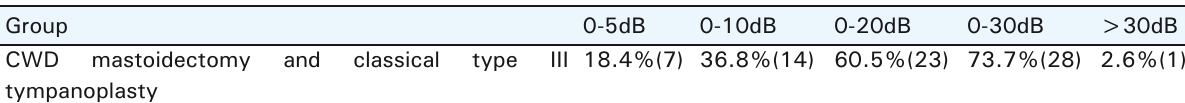
CWD mastoidectomy and classical type III tympanoplasty